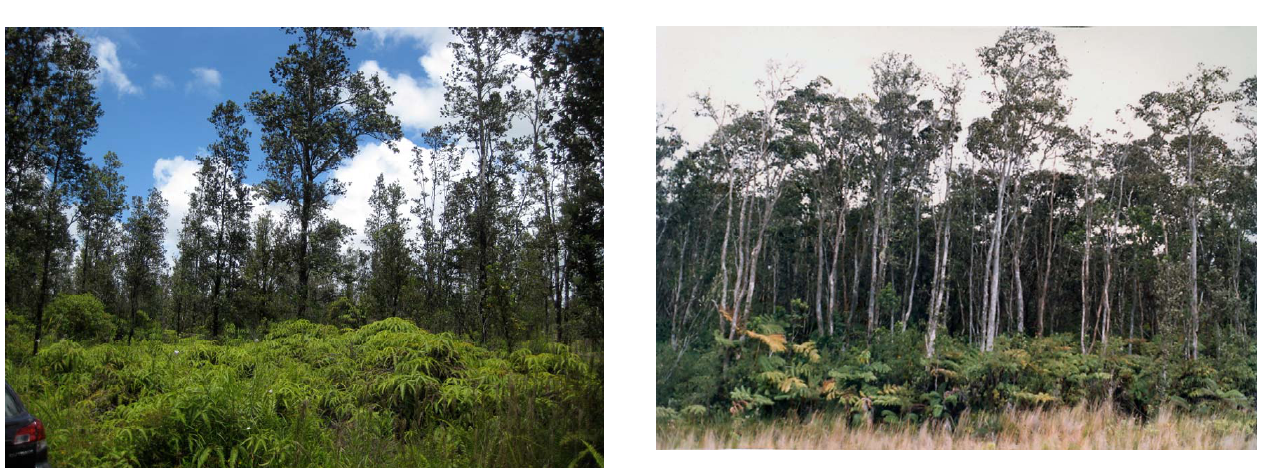
Fig. 3. Juvenile Metrosideros forest with uluhe fern ( Dicranopteris linearis ), a heliophytic mat-former. The young trees, growing typically in open formation, have short branches along their stems, and the undergrowth receives much direct sunlight (photo by D. Mueller-Dombois, 2011).